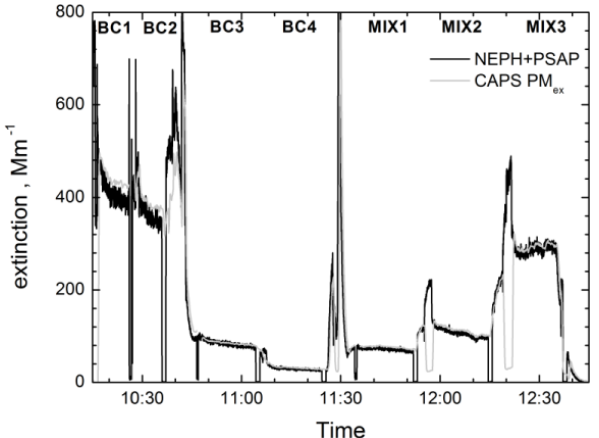
Fig. 5. Comparison of extinction at a wavelength of 630nm mea- sured by the CAPS PM ex instrument (y-axis) and extinction cal- culated for PSL spheres using the full size distribution information (a) and assuming monodisperse spheres at the nominal diameter (b) .